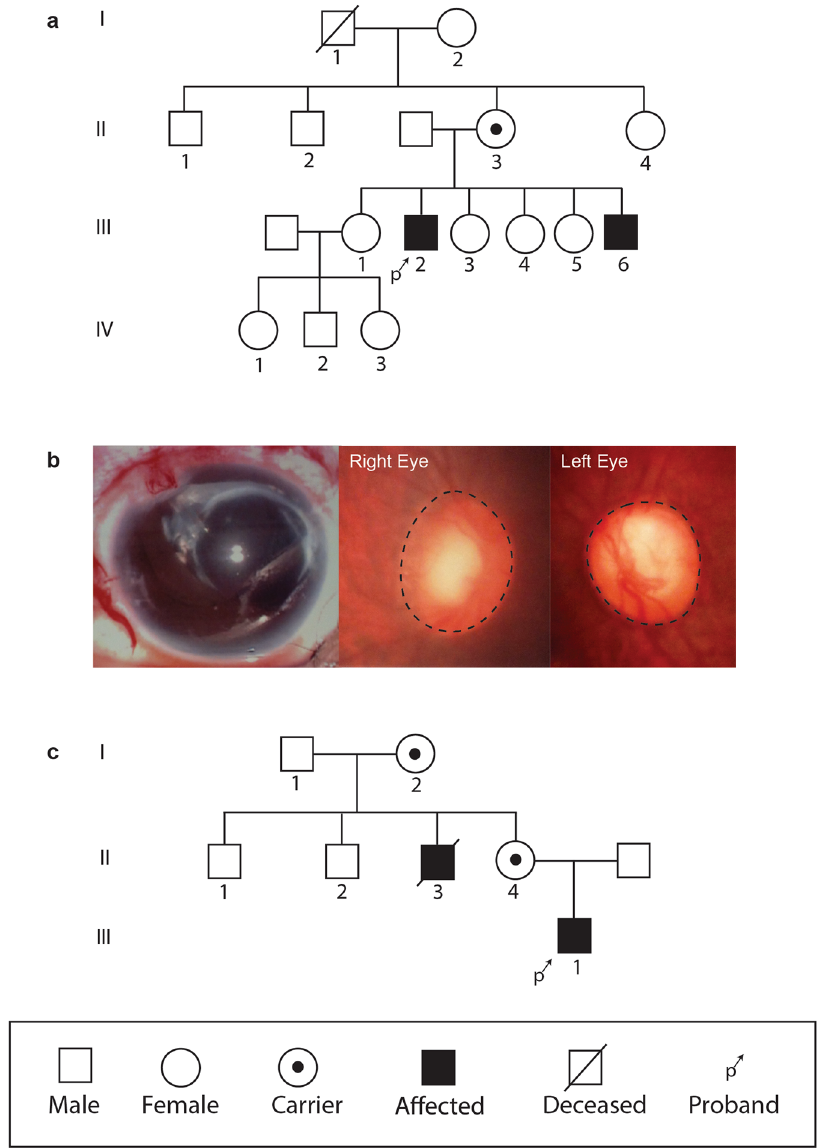
Figure 1. Pedigree and clinical presentation of Lowe patients. ( A ) Pedigree of Lowe patient 1 family, with affected males are denoted by a filled square. Examined female carriers are denoted by dotted circle. ( B ) Slit lamp photo of glaucoma drainage implant in the left eye and optic nerve photos of both eyes in Lowe patient 1. ( C ) Pedigree of Lowe patient 2